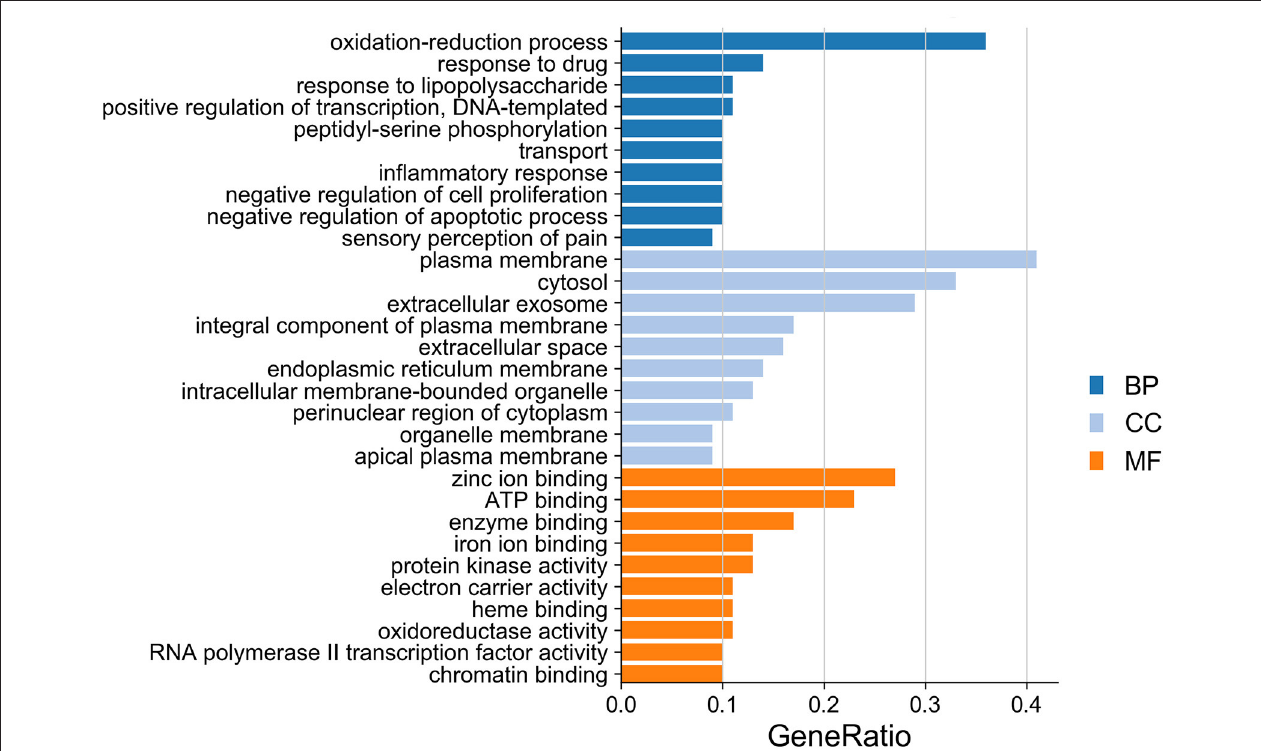
FIGURE 7 | GO enrichment analysis of targets in bar diagram. The top 10 significant enriched terms in biological process (BP), cellular components (CC), and molecular function (MF) are illustrated, respectively.